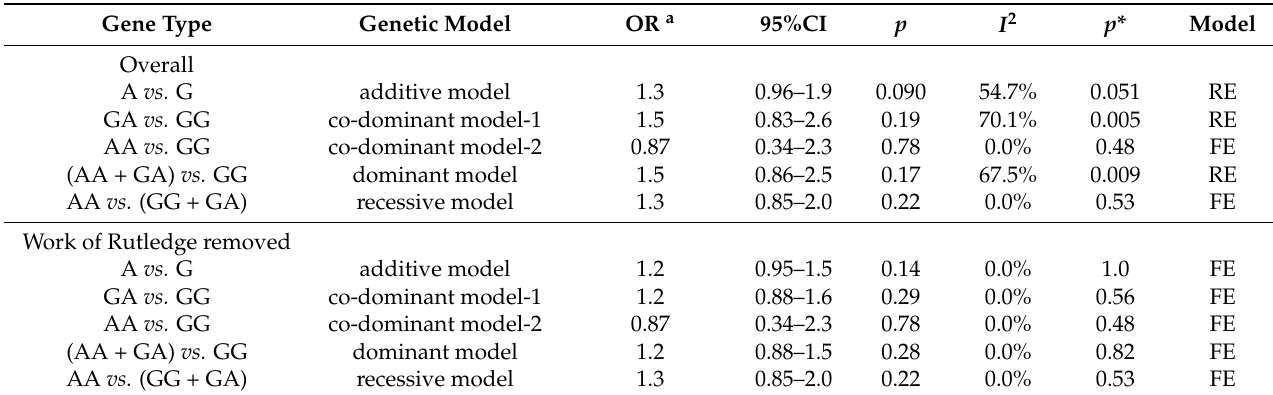
Table 4. Meta-analysis of G1837A polymorphism and